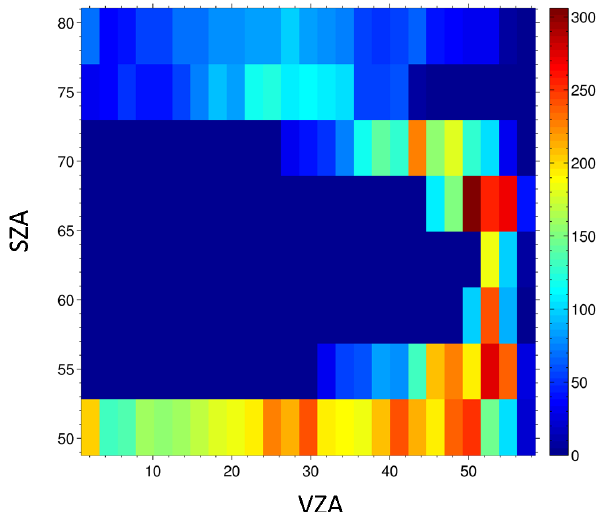
Figure 4. 2-D histogram of solar zenith angle (SZA) vs. viewing zenith angle (VZA) for the 1 ◦ × 1 ◦ grid boxes used as data points in this study. The colours represent the number of such data points at each pairing. Data have been filtered according to the criteria outlined in the